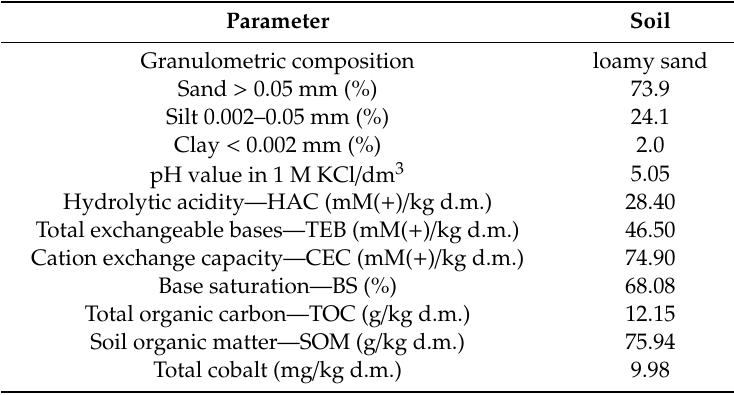
Table 1. Chemical composition of soil.